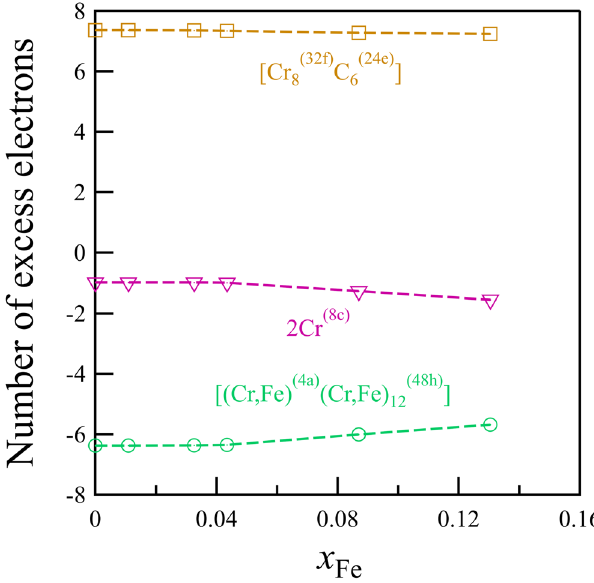
Figure 2. The number of excess electrons for the super-ions in γ -Cr 23 − x Fe x C 6 as obtained from a Bader charge analysis 39,40 as a function of x Fe for the most stable configurations at T = 0 K.